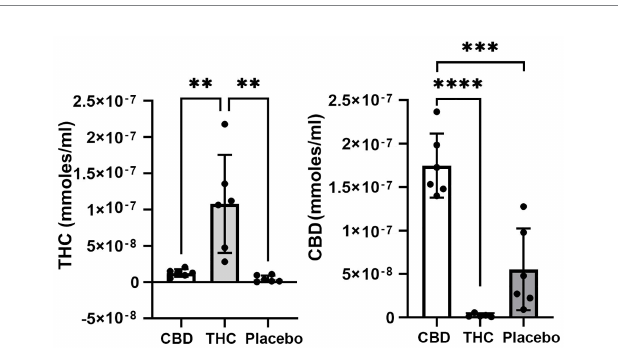
FIGURE 1 Plasma levels of Δ 9-THC and CBD. Shown are scatter plots for blood levels of Δ 9-THC and CBD in each of the experimental groups. Note the presence of CBD in mice exposed to placebo. ( ** p < 0.01; *** p < 0.001; **** p < 0.0001).